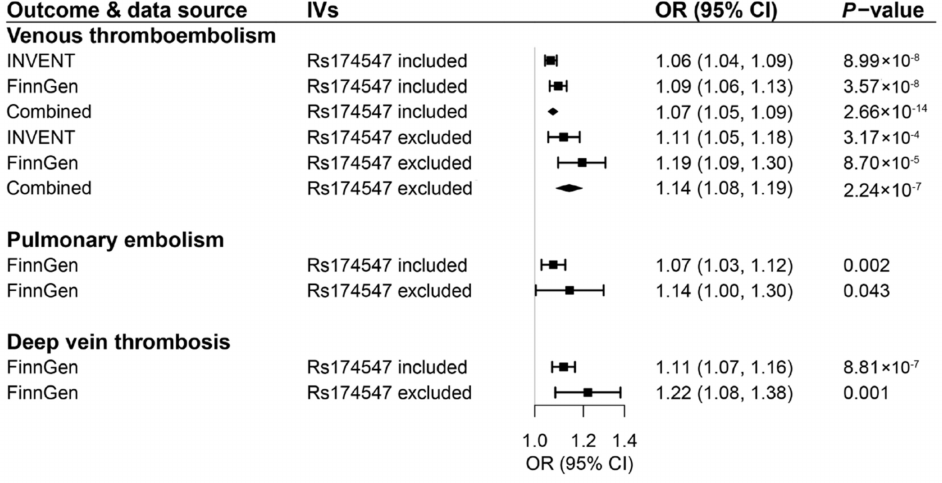
Figure 4. Associations of genetically predicted circulating levels of arachidonic acid based on a supplemental genetic instrument consisting of 9 or 8 SNPs with risk of venous thromboembolism and its two subtypes. CI indicates confidence interval; IVs, instrumental variables; OR, odds ratio. The associations were scaled to one standard deviation increment in genetically predicted circulating levels of fatty